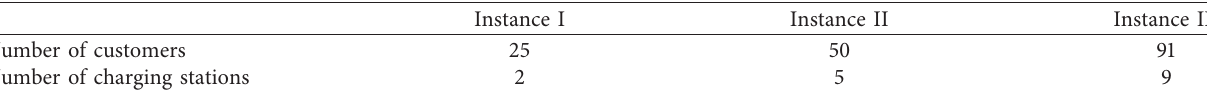
Table 3: Number of customers and charging stations.